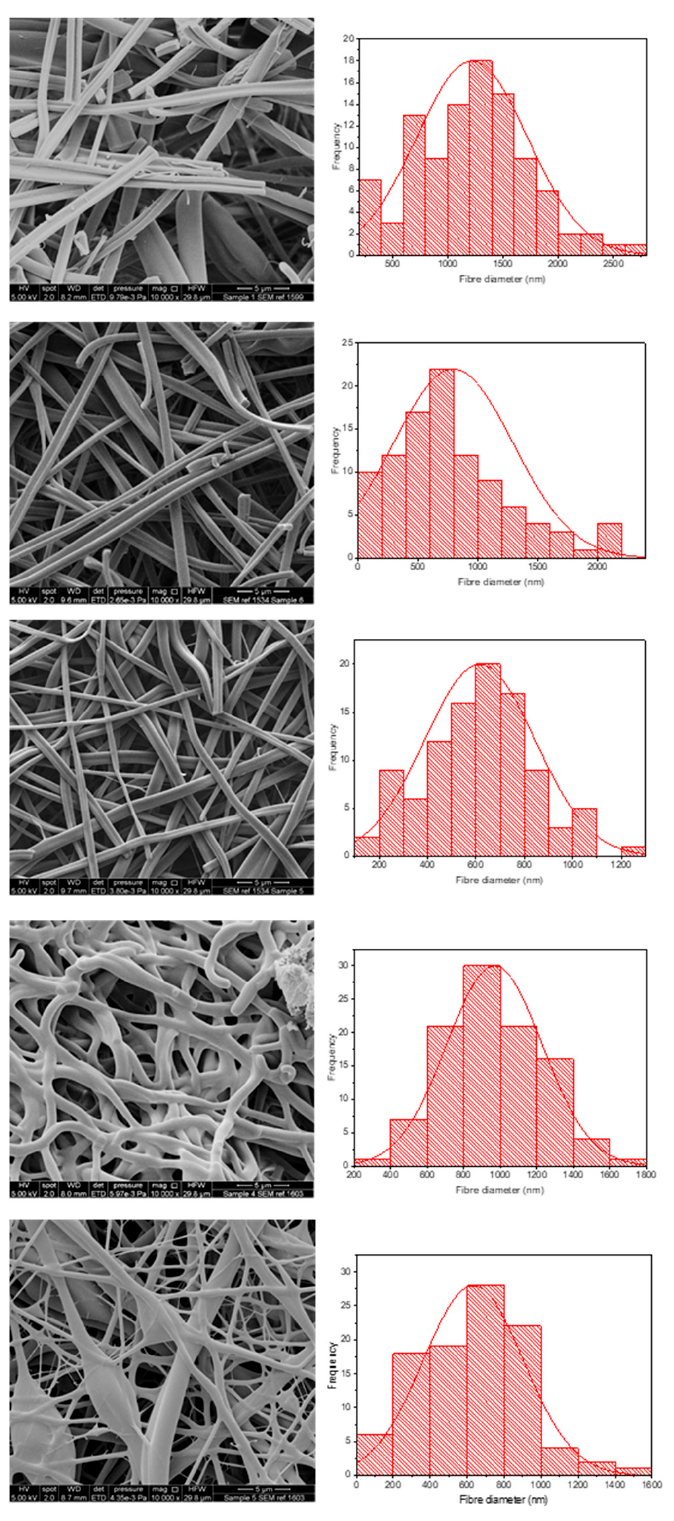
Figure 4. SEM images of the five formulations tested as listed in Table 1. The histograms represent distribution of fibre diameters. The images from top to bottom represent systems 1 to 5. Sample 1 is a placebo formulation whilst samples 2 to 5 contained CPM in the core.